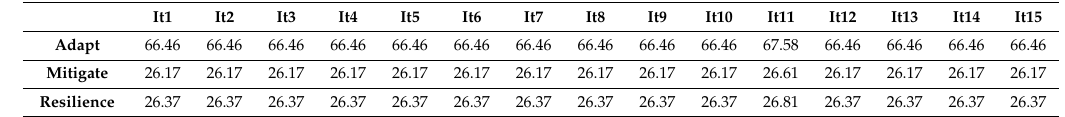
Table 9. Expected counts of data for Niger.